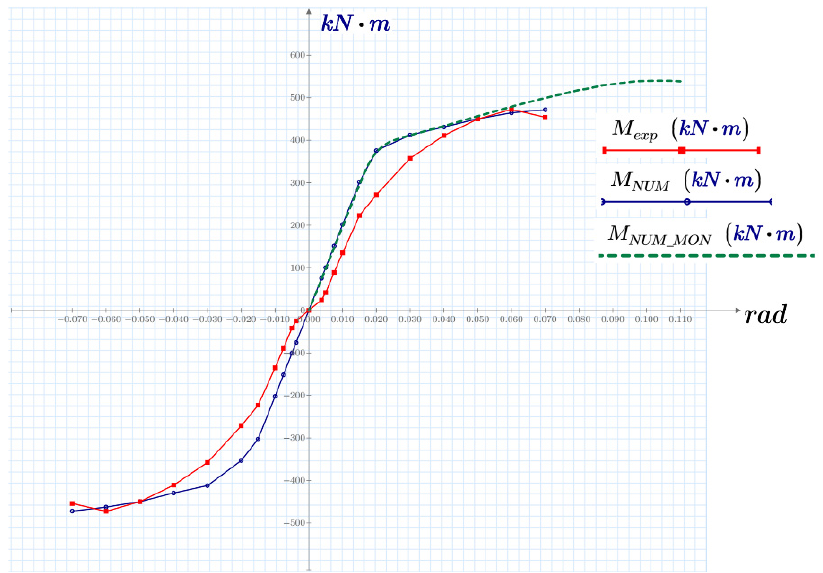
Figure 12. Moment–angle curve obtained by the numerical model under a monotonic displacement protocol ( M NUM_MON ). The curve is compared against the numerical ( M NUM ) and experimental cyclical envelopes ( M exp ).